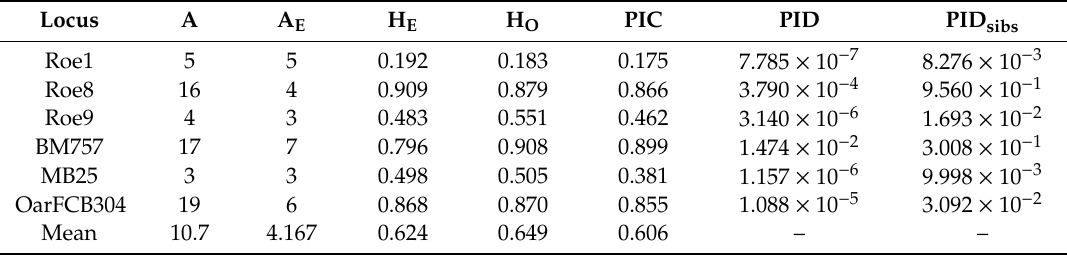
Table 1. Genetic diversity statistics, including number of allele (A), e ff ective number of alleles (A E: ); expected heterozygosity (H e ), observed heterozygosity (H O ), polymorphism information content (PIC), unbiased probability of identity (PID), and probability of identity for siblings (PID sibs ) for the six loci that were used to genotype the fecal DNA of Siberian roe deer in Liangshui National Nature Reserve in the Lesser Xing’an mountains, China in